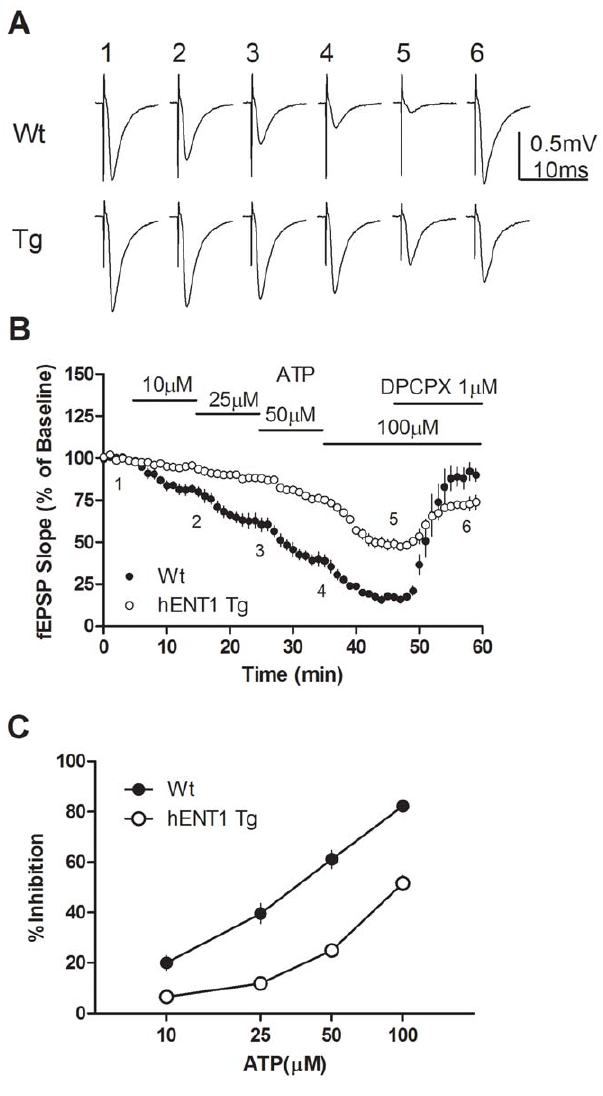
Figure 4. Inhibition by ATP of fEPSP recordings in hippocampal slices from hENT1 Tg and Wt mice. (a) Representative traces of fEPSPs; numbers 1–6 correspond to before and during superfusion of slices with ATP (10, 25, 50 or 100 m M) or ATP (100 m M) and DPCPX (1 m M) as indicated in (b). (b) The effect of ATP on fEPSP slope in hippocampal slices from hENT1 Tg and Wt littermate mice. Horizontal lines represent the duration of superfusion with the indicated ATP concentrations. (c) Maximum inhibition of fEPSPs obtained with each concentration of ATP. n =4 hENT1 Tg and 4 Wt.